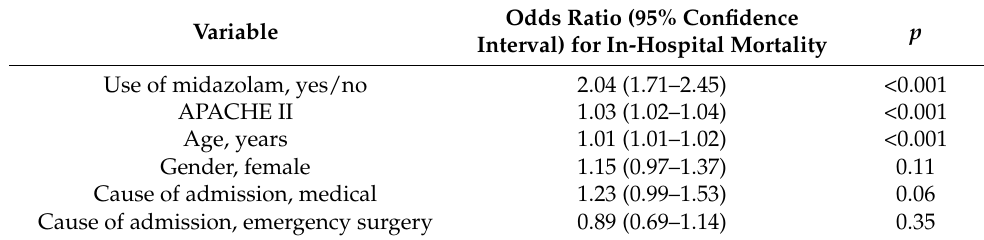
Table 5. Multivariable logistic regression for in-hospital mortality.